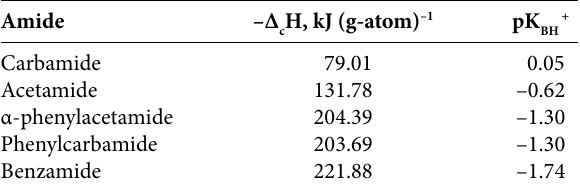
H (kJ(g-atom) –1 ) of amides and their ba- c + (r = 0. 992) BH